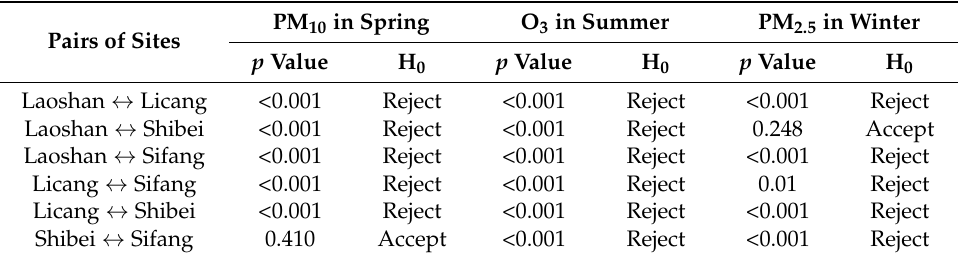
Table 5. Results of PM 10 , O 3 , and PM 2.5 difference test among the four sites.